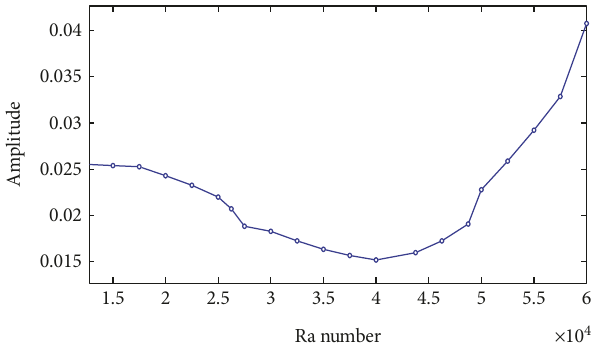
Figure 8: Disturbance amplitude in di ff erent Ra number when at T =6